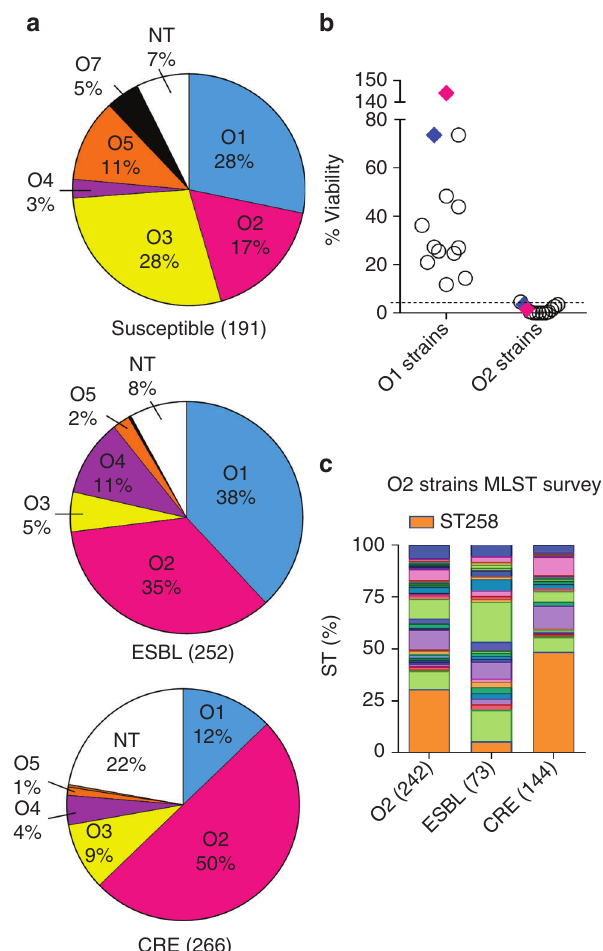
Fig. 1 Klebsiella pneumoniae serotype O2 prevalence in MDR strains. a LPS serotype-speci fi c antibodies were used to determine the serotype of 709 K. pneumoniae clinical isolates from 38 different countries by western blot. Pie charts represent the distribution of each serotype as a percentage of the total in each antibiotic resistant group. Susceptible, ESBL and CRE strains are categorized based on their MIC pro fi le as described in Methods. More information about the source of the isolates is listed in Supplementary Table 1. b Serum sensitivity assays were performed in 45% pooled human sera using a panel of 12 O1 isolates, 12 O2 isolates and two separate isogenic pairs genetically converting an O2 strain to O1 (Kp961842, magenta diamonds) or an O1 strain to O2 (Kp1131115, blue diamonds). Percent viability is the ratio between CFUs present in buffer control media and CFUs present in human sera after 2 h growth. c A subset of serotype O2 isolates was further analyzed by Sanger or next generation sequencing to determine ST types. The CRE ST258 sequence type is represented by the shaded orange portion of each bar to highlight the percent of ST258 isolates observed in each